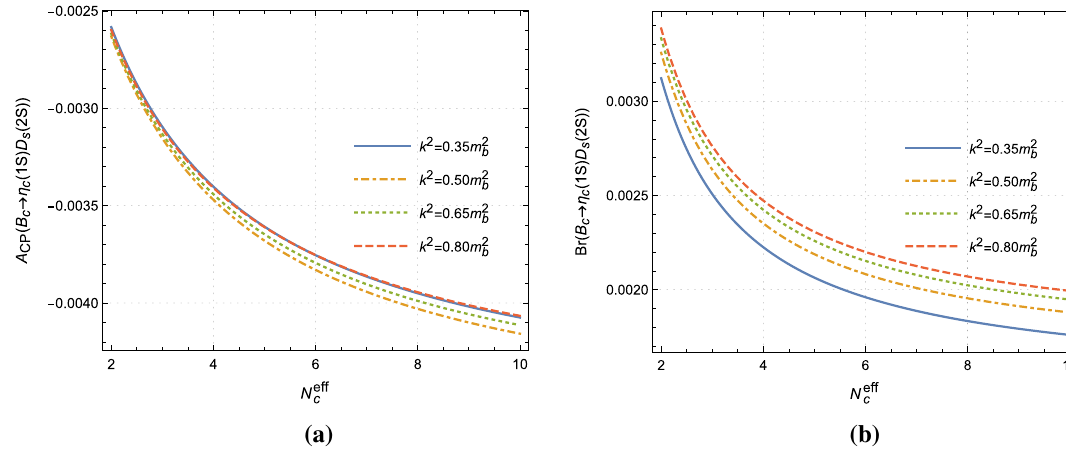
Fig. 3 A cp and averaged branching ratio of B c → ψ( 1 S ) D ( 2 S ) change with k 2 and N ef f c